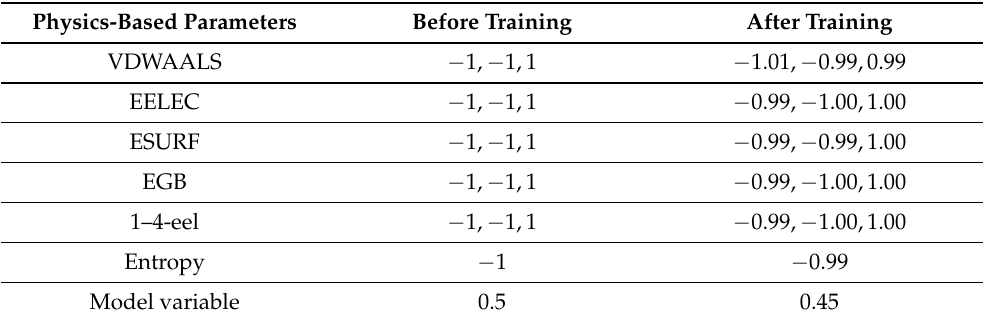
Table 4. Coefficients of the physics-based features and the model variable in the last dense layer before and after